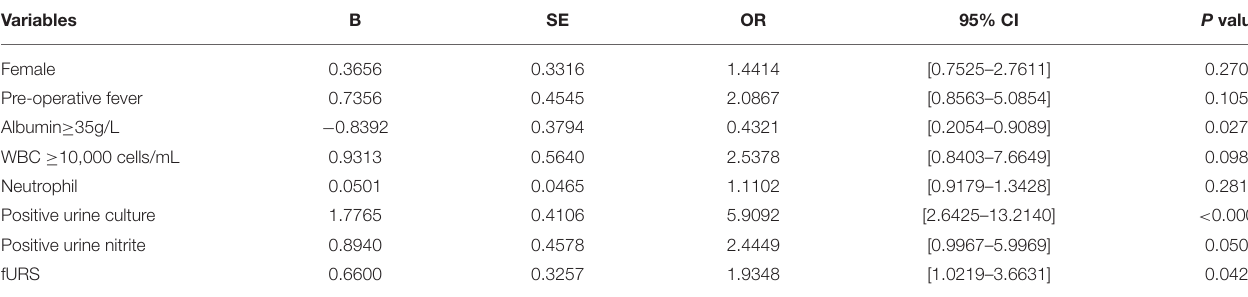
TABLE 2 | Multivariable logistic regression analysis of predictors of sepsis.